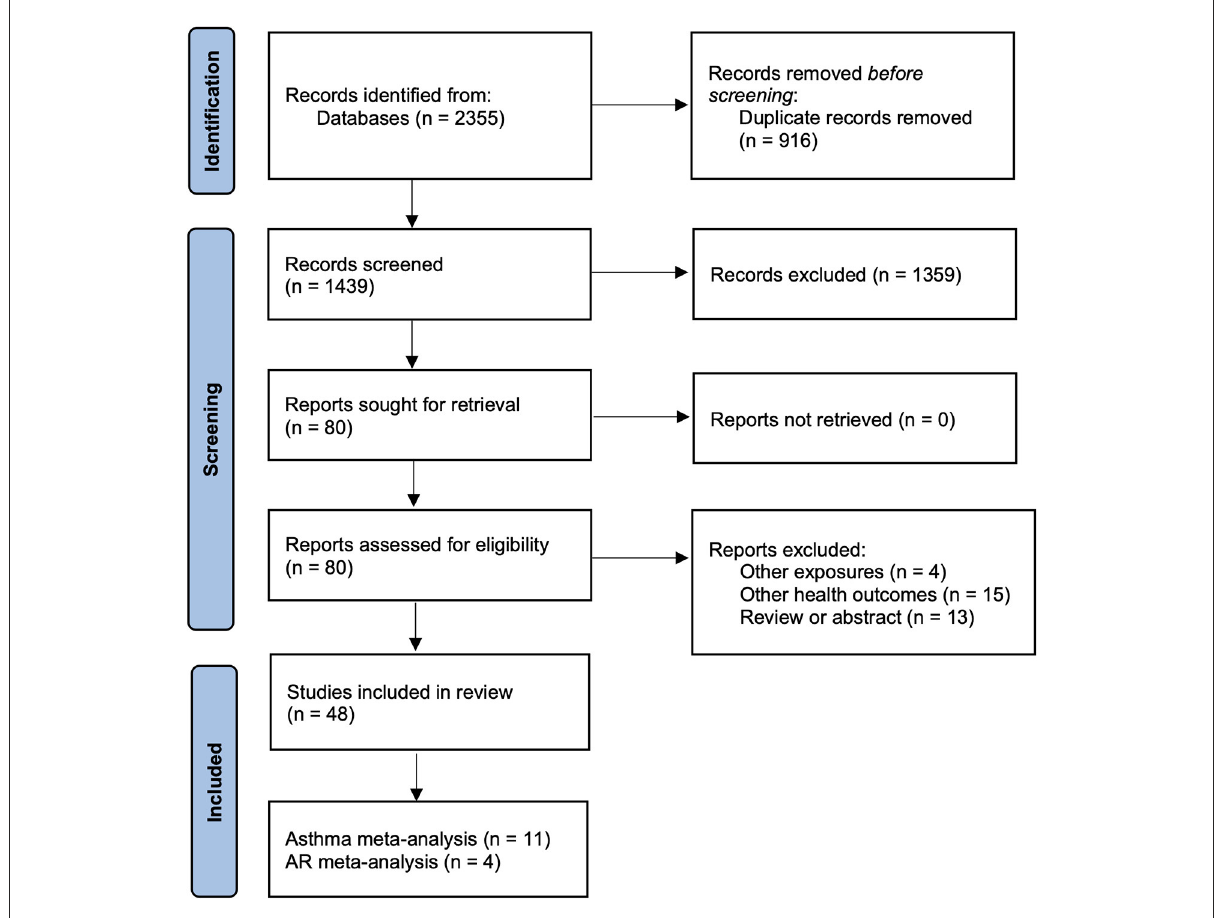
FIGURE1 PRISMA flowchart for search